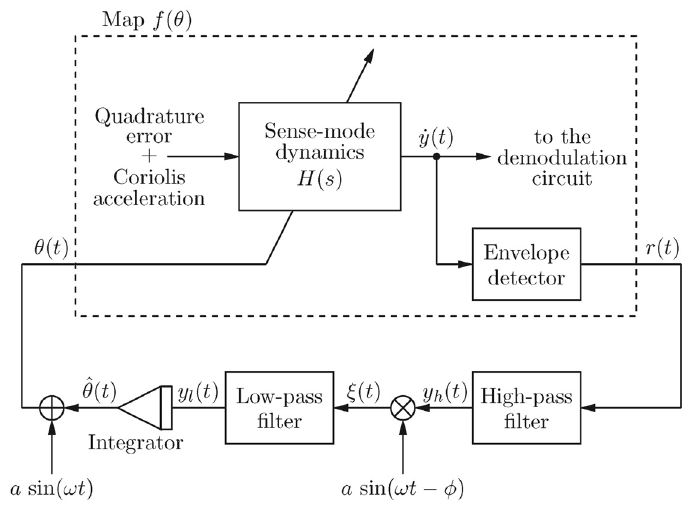
Figure 10. Block diagram of the proposed mode-matching control loop by Trento.